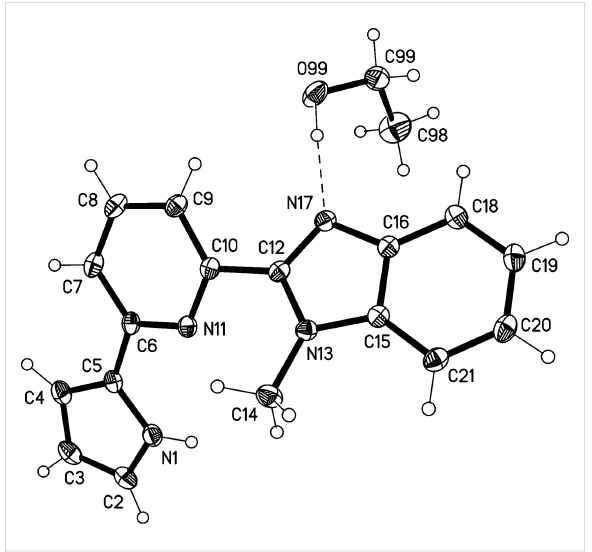
Figure 5: The structure of compound 3 ·C 2 H 5 OH in the crystal. Ellip- soids correspond to 50% probability levels. Hydrogen bond details (Å,°) for O99–H99 … N17: H … N 1.91(2), O … N 2.813(1), O–H … N 174(2).